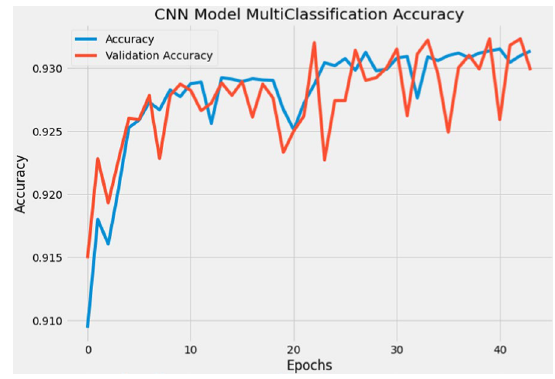
Fig. 13 Training and validation accuracy of CNN